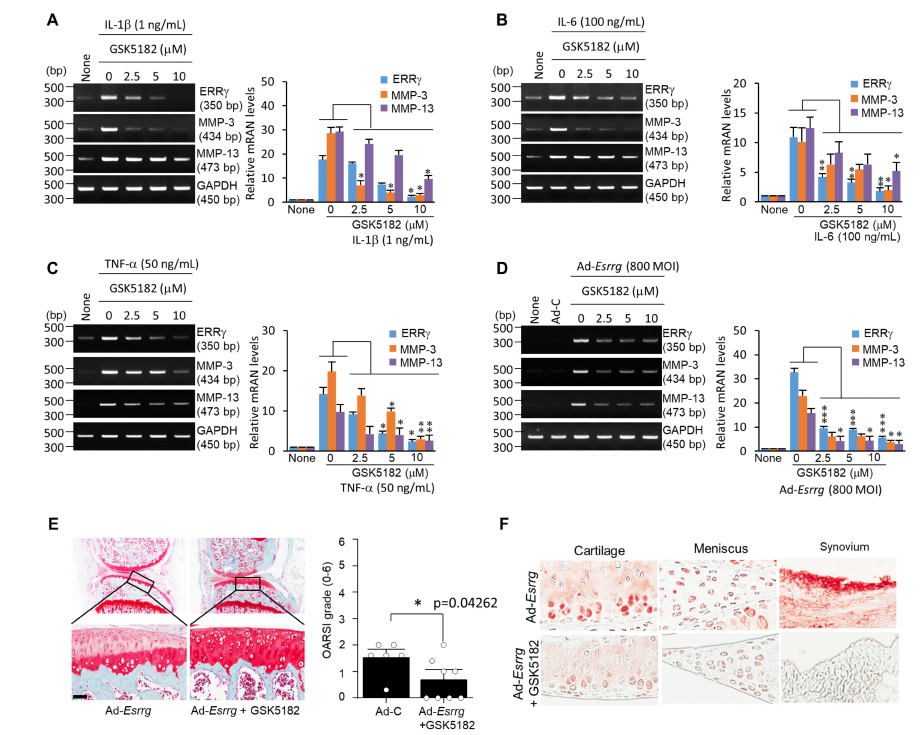
Figure 4. GSK5182, an inverse agonist ERR γ , suppresses OA pathogenesis in vitro and in vivo. RT-PCR or qRT-PCR analyses of ERR γ , MMP-3, and MMP-13 expression in chondrocytes treated with IL-1 β (1 ng mL − 1 ) ( A ), IL-6 (100 ng mL − 1 ) ( B ), and TNF- α (50 ng mL − 1 ) ( C ) at indicated concentrations of GSK5182. ( D ) mRNA levels of ERR γ and MMPs (MMP-3 and MMP-13) were analyzed by RT-PCR or qRT-PCR in primary cultured chondrocytes infected with Ad- Esrrg (800 MOI)